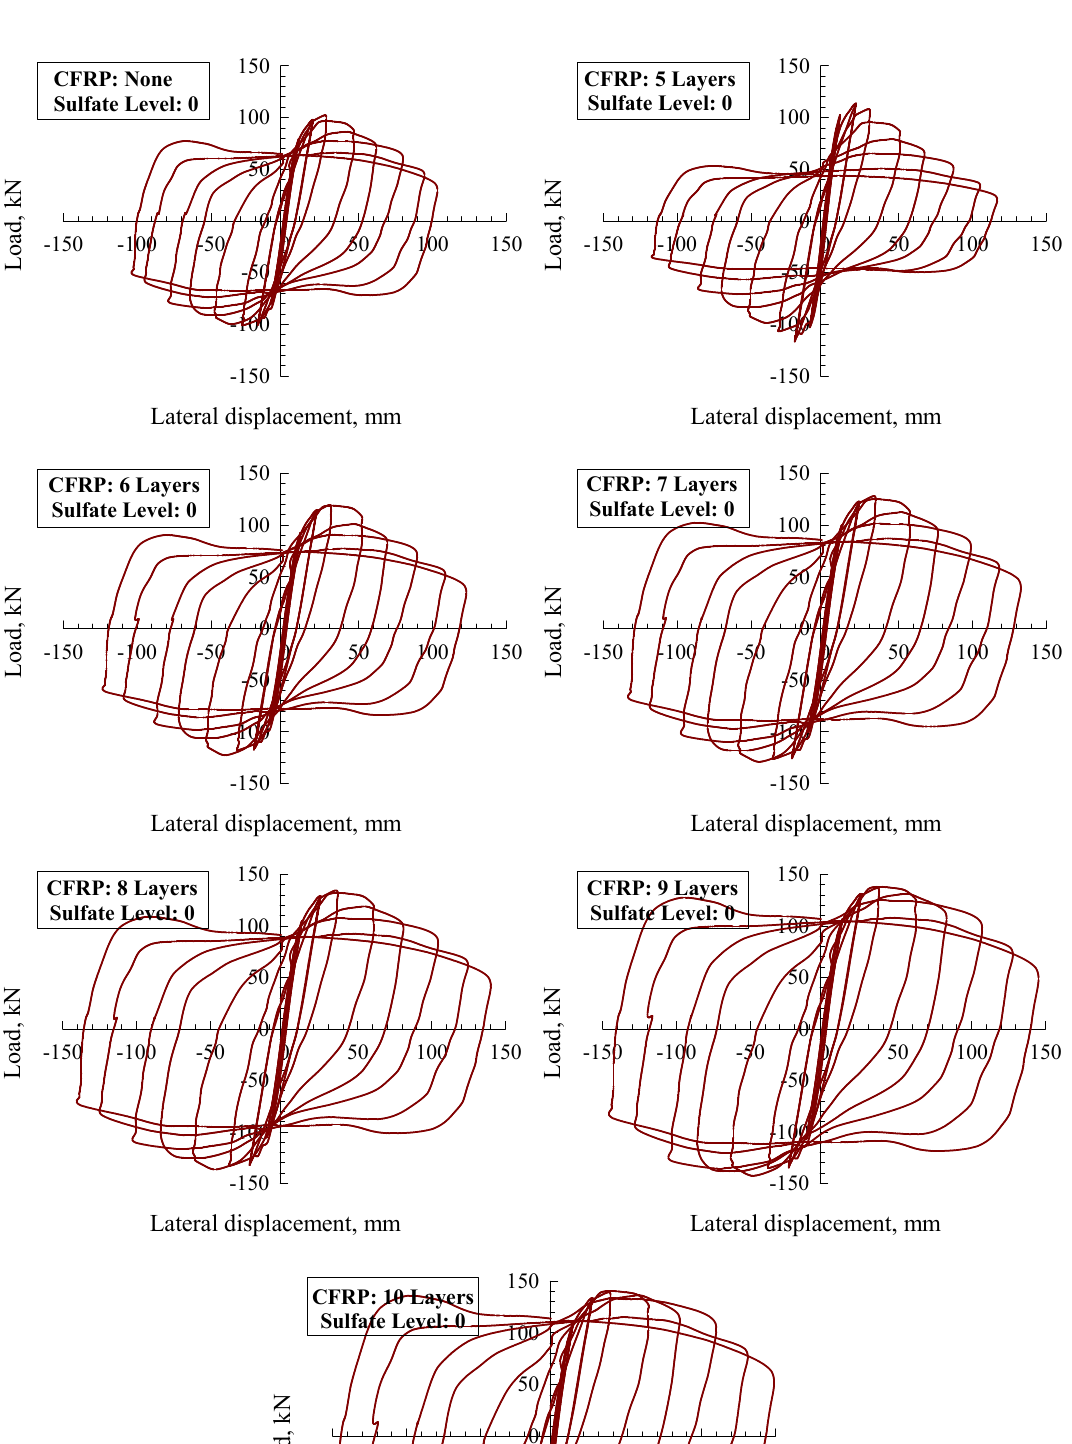
Figure 6. Typical stress contours for sulfate level 1: ( a ) CFRP, ( b ) concrete, and ( c ) steel tube.